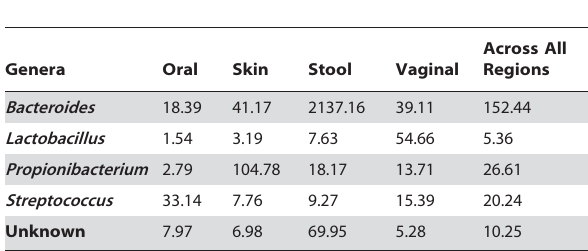
Table 4. Expected OTUs per 100,000 reads represented for the most common genera across body